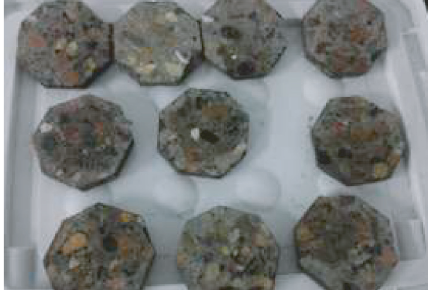
Figure 5: Experimental samples of RapidAir457.